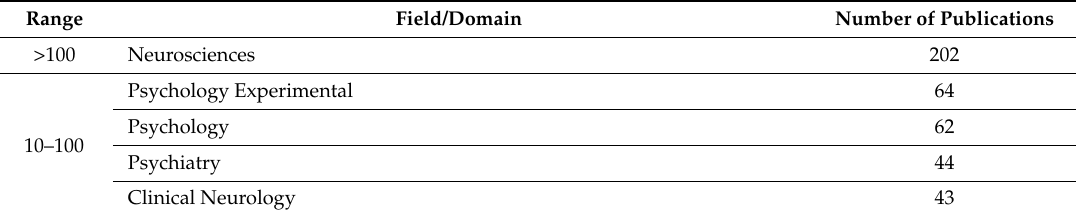
Table A1. Distribution of the results according to the Web of Science